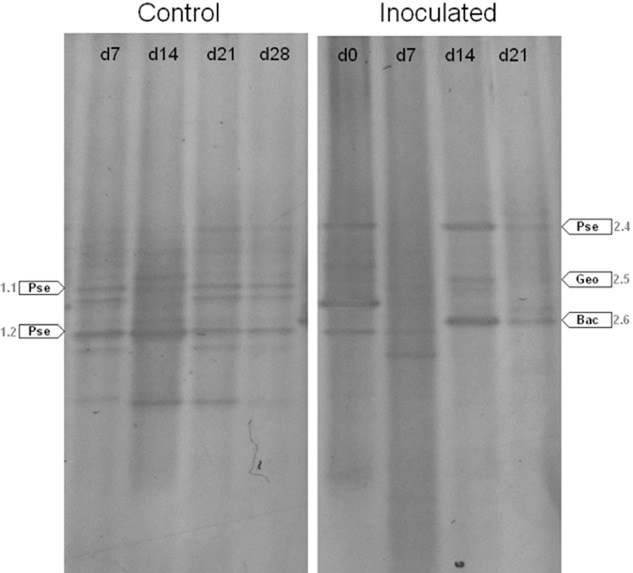
DGGE analysis of the anodic bacterial communities of the MFCs at different time points during the enrichment period. The note on each lane of a gel indicates the moment the sample was taken (for example, d7 = at the 7th day). A sample at d0 indeed resembles the corresponding inoculum. The note on each white arrow indicates the genus, 16S rDNA sequence of which has the highest similarity (> 98%) to the DNA sequence of the corresponding band on the gel (based on BLAST analysis). Pse = Pseudomonas sp., Geo = Geobacter sp., Bac = Bacillus sp. (The note next to each arrow is the assigned number of the corresponding band). The DGGE was repeated three times with three replicates of each sample. As the results of these repetitions were absolutely similar, only typical patterns were shown here.